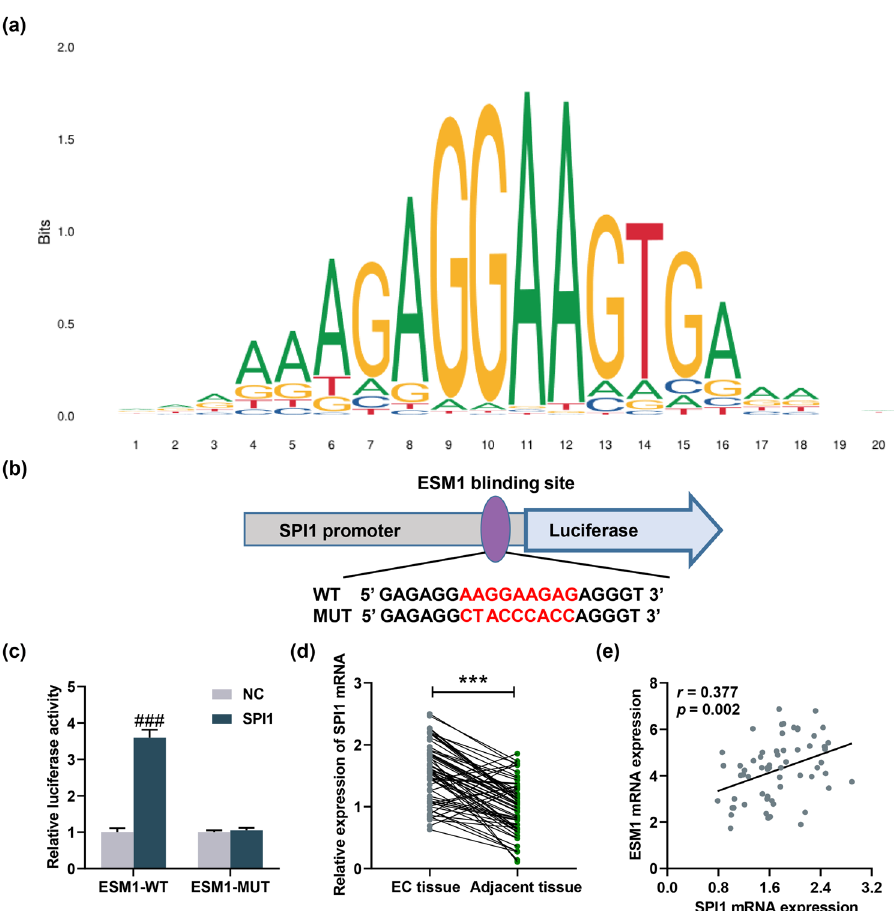
Figure 6: ESM1 was induced by SPI1, which was highly expressed in EC. ( a ) The motif logo of SPI1 was analyzed by JASPAR ( http://jaspar. genereg.net/analysis ) . ( b ) The ESM1 - binding sites with the SPI1 promoters. ( c ) SPI1 bound to ESM1, which was veri fi ed by dual - luciferase reporter assay. ( d ) The expression of SPI1 in the cancer tissues and adjacent tissues of 64 EC patients was quanti fi ed by qRT - PCR, and SPI1 was highly expressed in EC tissues. ( e ) The correlation between SPI1 expression and ESM1 in EC tissues was analyzed by Pearson test, the results of which indicated that SPI1 was positively related to ESM1. *** P < 0.001 vs EC tissue; ### P < 0.001 vs